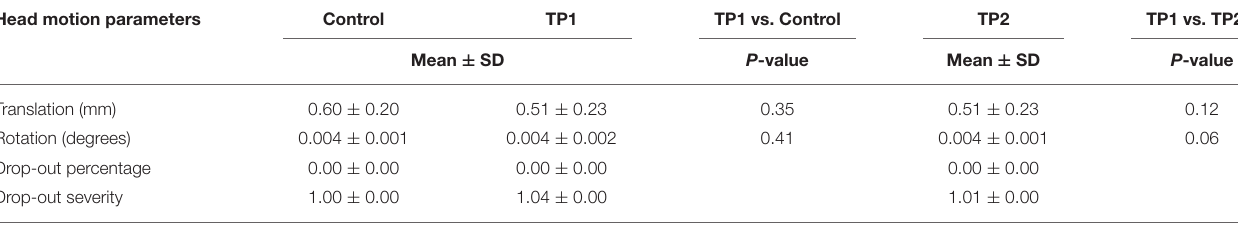
TABLE 2 | Head motion parameters for the patients in pretreatment (TP1), post-treatment (TP2), and controls.